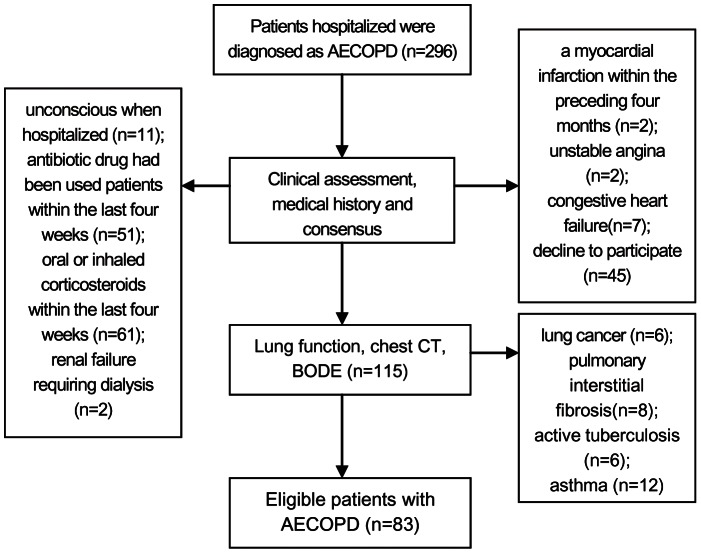
Strategies for screening patients with AECOPD.